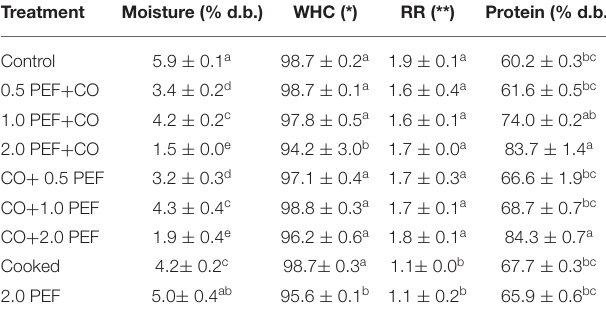
Lowercase letters indicate the statistical significance (p < 0.05) among all the treatments compared with each other (column). * Water holding capacity (WHC): g retained water/100g water, ** RR: g absorbed water/g